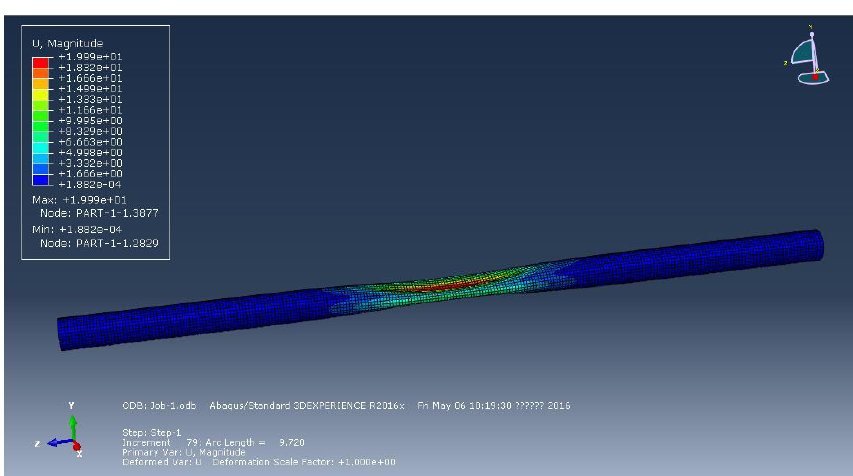
Figure 2. Deformation of pipeline at ellipticity of 0.001.